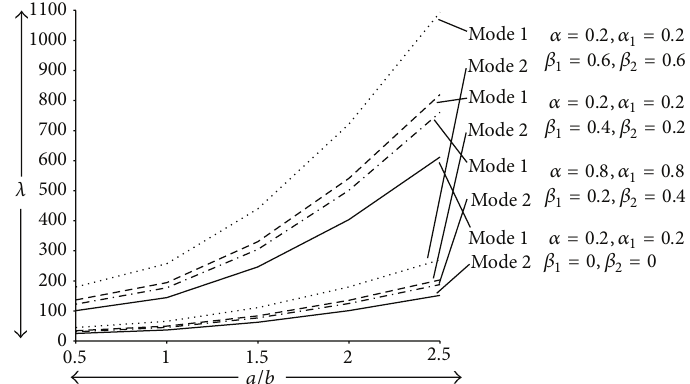
Figure 5: Frequency versus aspect ratio ( a / b